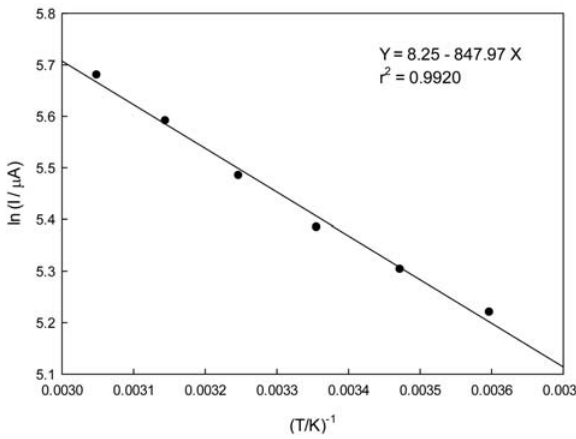
Figure 6. Plot of ln( I ) vs. T –1 for response anodic peak current of pa polymer film in a phosphate buffer solution at pH 5.0 containing 2.0 mM of catechol at a scan rate of 50 mV s –1